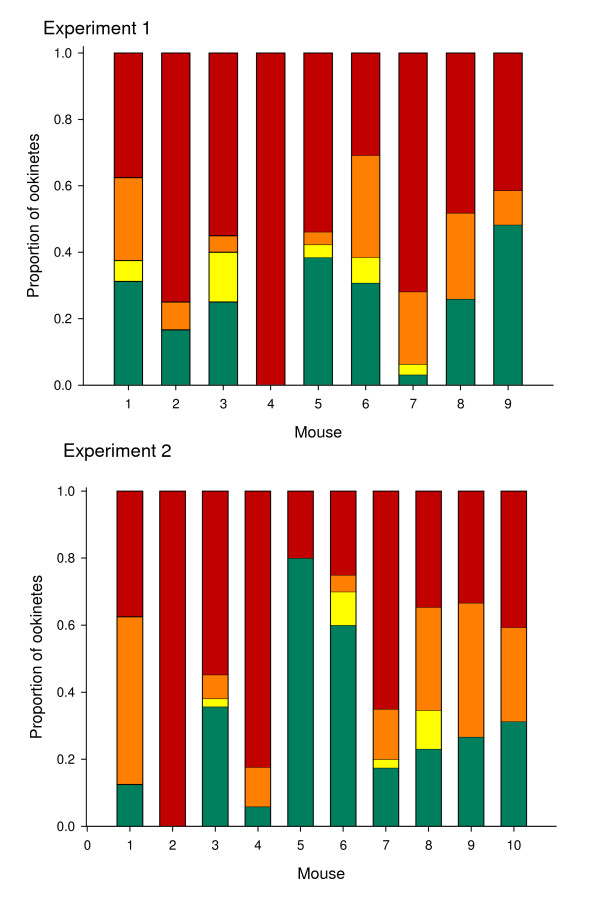
Replicate experimental infections show variation for proportions of parasites showing caspase-like activity and viability. Two sets of replicate experiments were set up by infecting 10 male MF1 mice 8-10 weeks old per replicate with 107 P. berghei parasites after pre-treatment with Phenylhydrazine 2 days pre-infection (120 mg/kg). One mouse from experiment 1 failed to become infected so was removed from the study. Cultures were then set up 4 days post infection. After 18 hours ookinetes were purified using MACS LS cell separation columns (Miltenyi biotec) and a minimum of 30 parasites were assayed for caspase like activity and viability using CaspaTag™ Pan-Caspase In Situ Assay Kit, Fluorescein in conjunction with propidium iodide (Chemicon international, USA). Green indicates healthy ookinetes negative for caspase-like activity with intact membranes, yellow indicates early apoptotic ookinetes displaying caspase-like activity with intact membranes, orange indicates late apoptotic ookinetes displaying caspase-like activity but also compromised membranes and red indicates dead cells with compromised membranes [25]. More detailed methodology is available in Additional file 1.